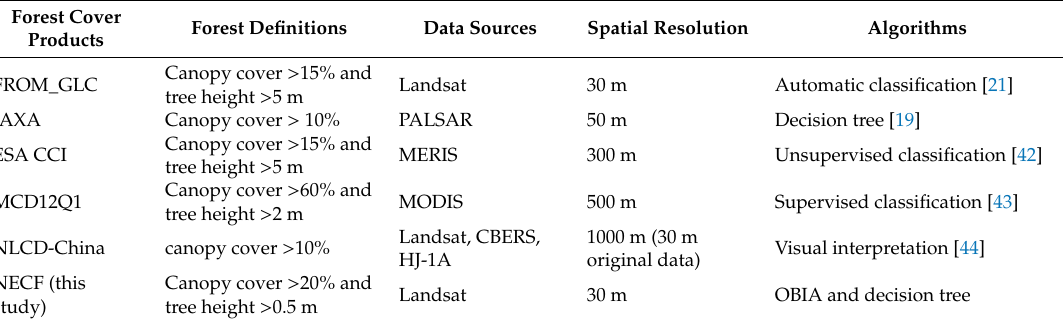
Table 1. Characteristics of selected forest cover products used in this study.